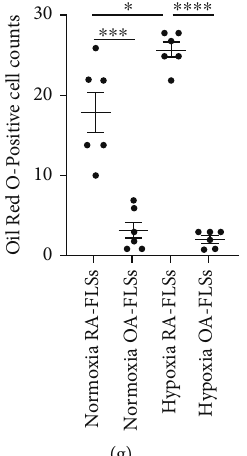
Figure 2: Maintenance of the phenotype and self-renewal capacity of RA-FLSs under hypoxic condition and Hypoxia inhibits osteogenesis but increases adipogenesis of RA-FLSs. (a) Percentage of MSC-like cells of the RA-FLSs and OA-FLSs exposed to normoxic and hypoxic conditions for 48 hours (three independent experiments). (b) Colony formation assays of RA-FLSs and OA-FLSs exposed to normoxic and hypoxic conditions for 14 days. Data quanti fi cation is mean ± SEM . ( t -test, three independent experiments). (c, d) RA-FLSs and OA- FLSs induction of osteoblast di ff erentiation after culture in OIM for 21 days, and then stained by Alizarin Red solution. (e) Alizarin Red positive cells per fi eld were counted. Data quanti fi cation is mean ± SEM . ( t -test, six randomized fi elds, three independent experiments, and one representative experiment shown). (f) RA-FLSs and OA-FLSs induction of adipocyte di ff erentiation after culture in AIM for 21days, and then stained with Oil Red O solution. (g) Oil O Red positive cells per fi eld were counted. Data quanti fi cation is mean ± SEM . ( t -test, six randomized fi elds, three independent experiments, and one representative experiment shown). ∗ p < 0 : 05 , ∗∗∗ p < 0 : 001 , ∗∗∗∗ p < 0 : 0001 . Scale bars: C = 50 μ m